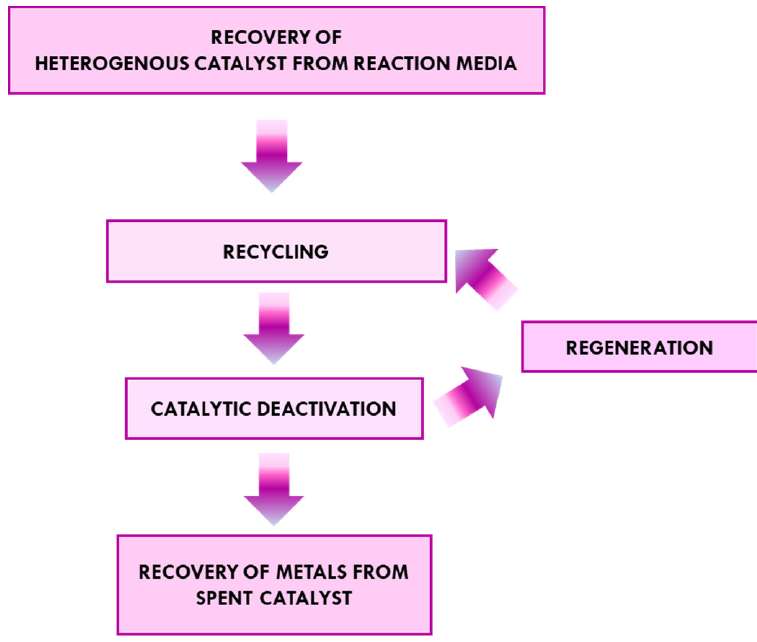
Figure 1. The catalyst’s life cycle.